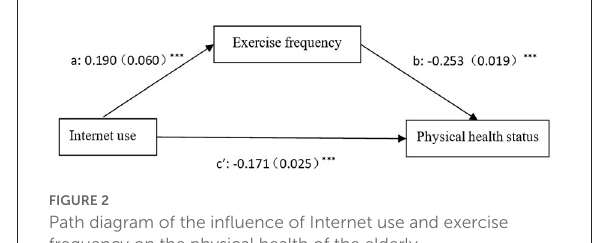
FIGURE2 Path diagram of the influence of Internet use and exercise frequency on the physical health of the